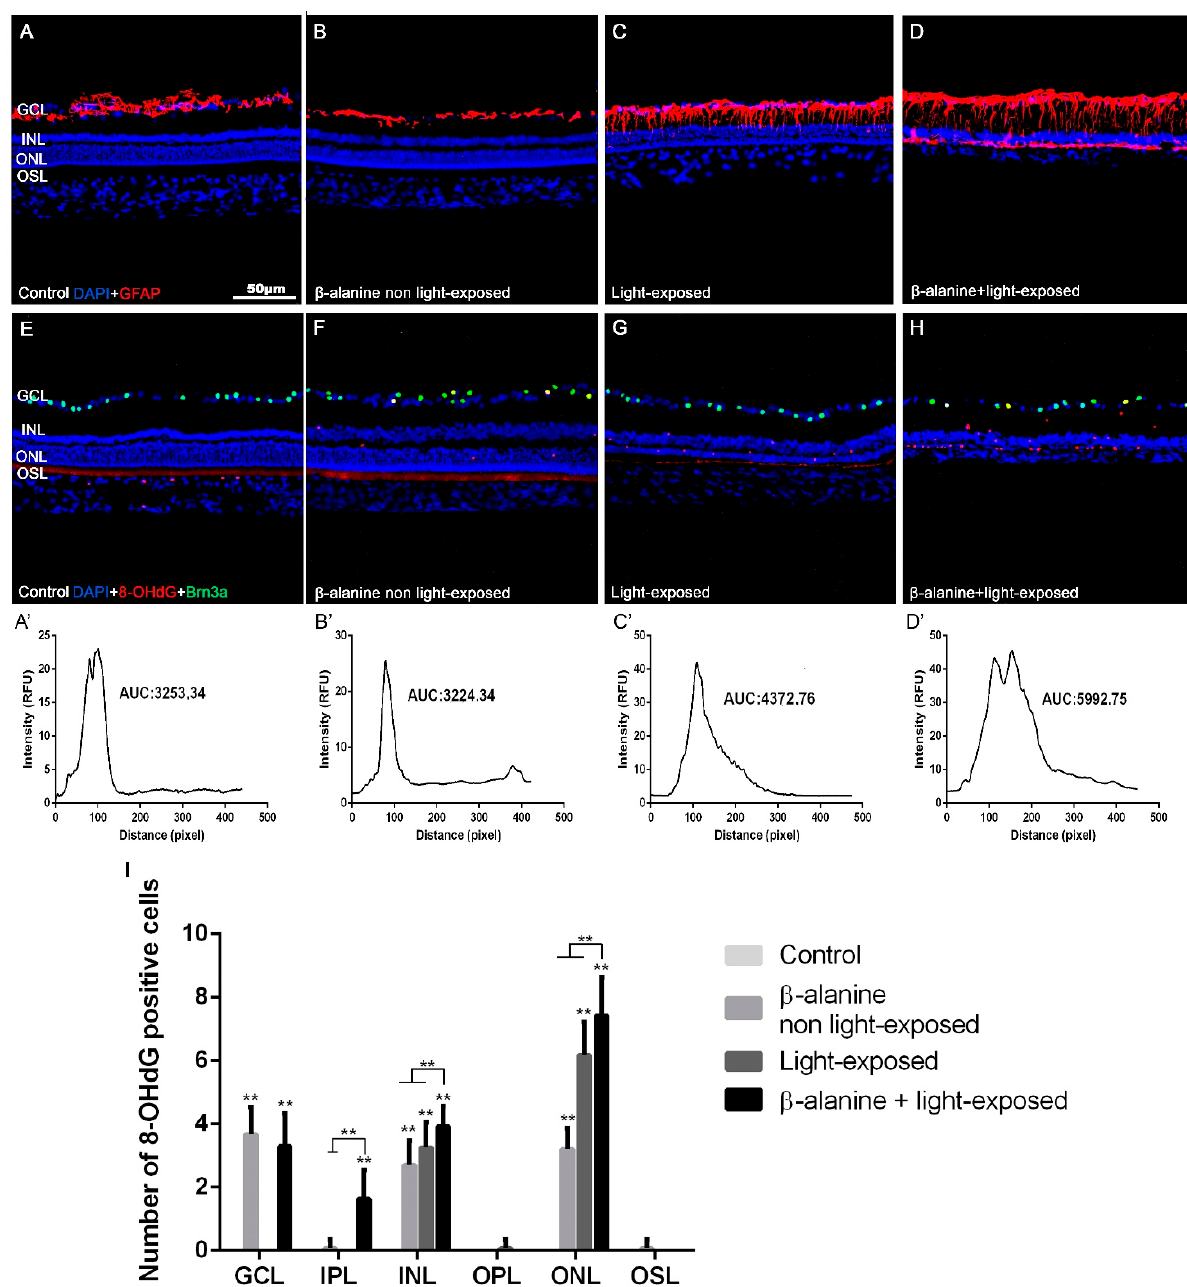
Figure 5. GFAP immunoreactivity and oxidative stress. Photomicrographs of retinal cross sections taken from representative animals of the different subgroups: control ( A , E ), β -alanine non light- exposed ( B , F ), light-exposed ( C , G ) and combined β -alanine and light-exposed ( D , H ) rats, showing GFAP ( A – D , red ) immunoreactivity, 8-OHdG+ cells and Brn3a+ cells ( red and green , E – H ) and DAPI nuclear counterstaining ( blue , A – H ). The GFAP immunoreactivity can be observed in astrocytes ( A – D ) and Müller cells ( B – D ), while the 8-OHdG+ immunoreactivity is observed in the photoreceptor outer segments in all subgroups ( E – H ), in some cells in the different retinal layers in the three experimental subgroups and, specifically, in retinal ganglion cells in both β -alanine treated groups. Graphs showing mean GFAP intensity in each experimental group and the area under the curve (AUC; A’ – D’ ) and mean numbers of 8-OHdG positive cells per retinal layer ( I ). Scale bar: 50 µm. ** Significant differences when compared to other subgroups ( p ≤ 0.001). GCL: Ganglion cell layer. IPL: Inner Plexiform Layer. INL: Inner nuclear layer. OPL: Outer Plexiform Layer. ONL: Outer nuclear layer. OSL: Outer segments layer.